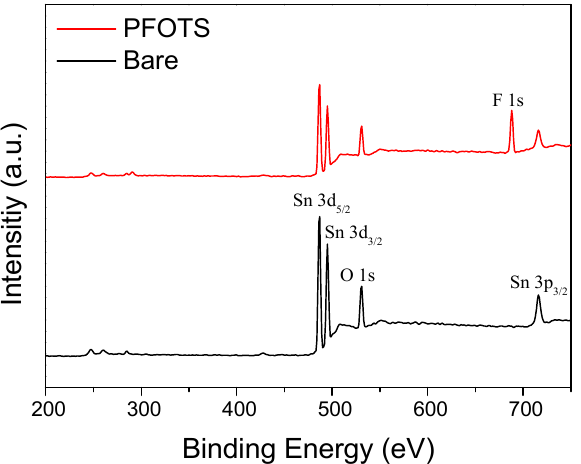
Figure 2. XPS survey spectrum of porous SnO 2 film before and after PFOTS coating.